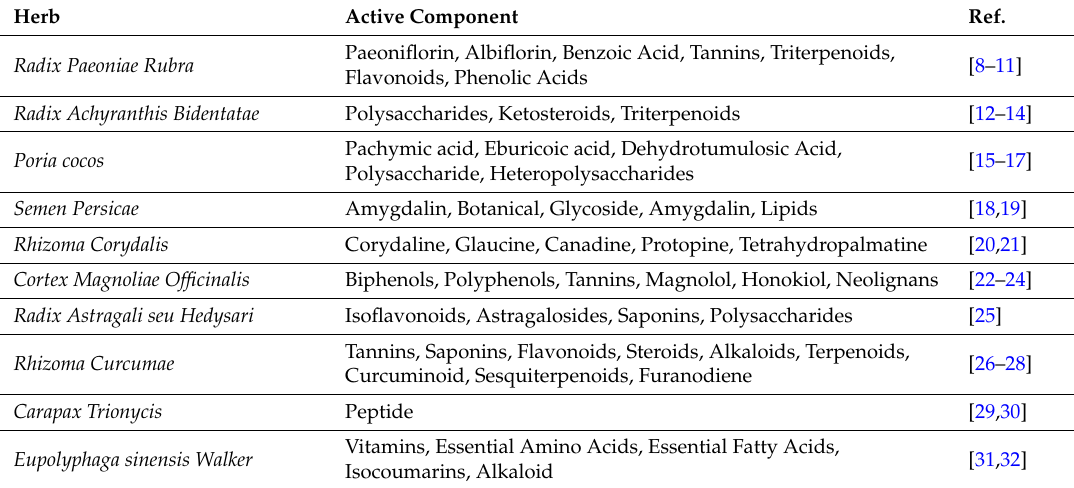
Table 1. The information of the main active components of JGG